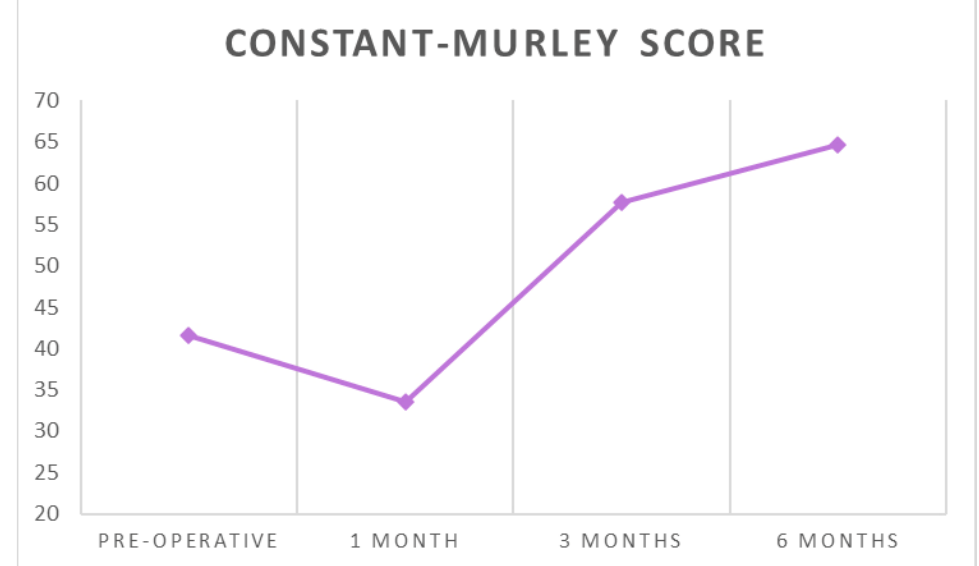
Figure 6. The average Constant scores at each follow-up timepoint.